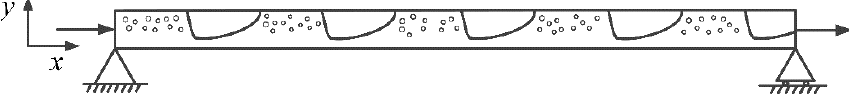
Figure 1. Schematic of a simply supported pipe conveying two-phase slug flow.